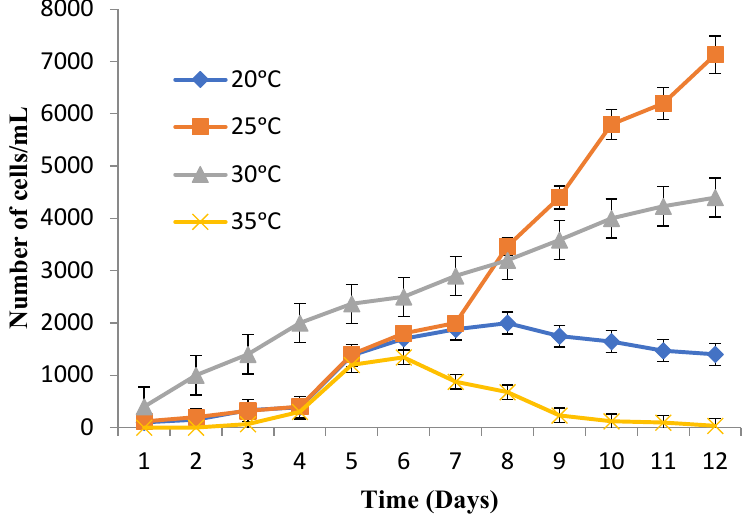
Figure 2. Growth observations of Paramecium multimicronucleatum culture provided with different temperatures.